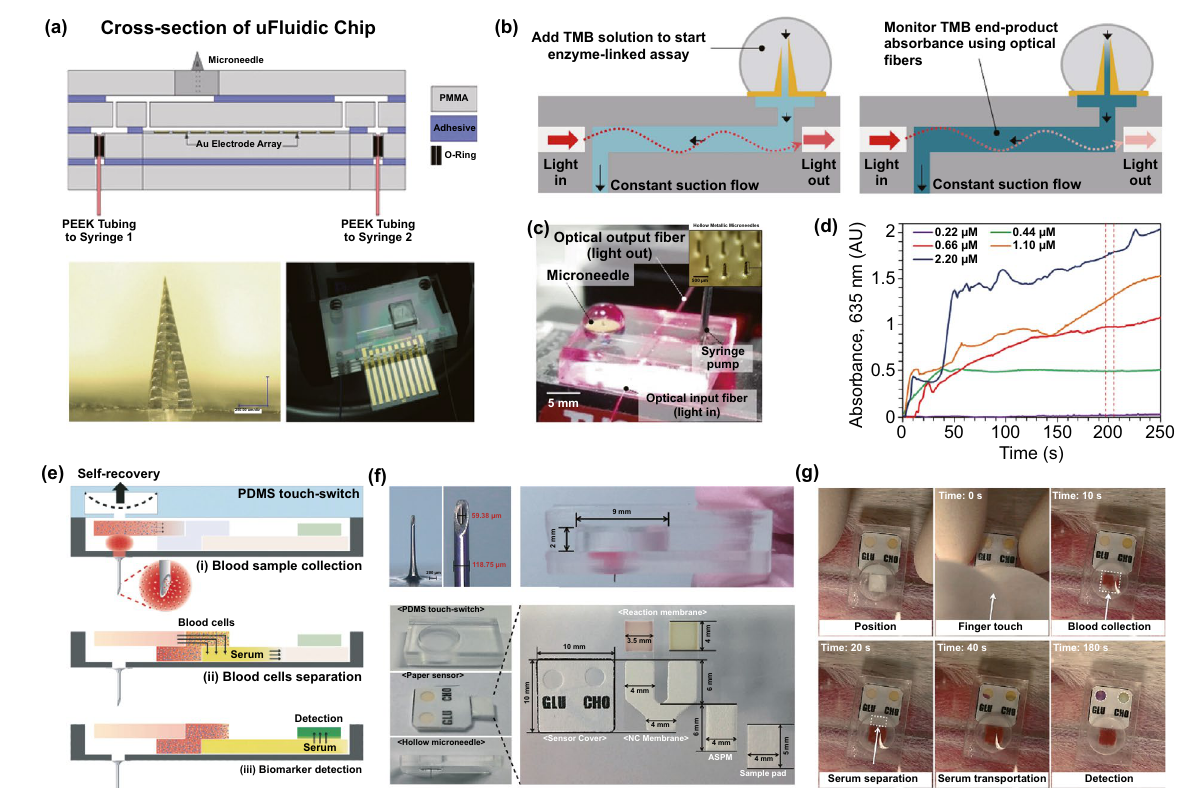
Fig. 14 Microneedle‑based biosensors for proteins and serum analytes detection. a Hollow microneedles and fluidic channels integrated bio‑ sensor developed for myoglobin/troponin detection in ISF [240]. b–d Hollow‑microneedle‑optofluidic biosensor for rapid in vitro vancomycin (VAN) sensing [241]. b Cross‑sectional schematics of the device and the mechanism of optofluidic analyzing. c Image of integrated device while analyzing. Inset: the micrograph of the hollow microneedles. d Absorbance spectra of different concentration of analytes binding to the microneedle‑lumen. e, f A fully integrated, one‑touch‑activated blood multidiagnostic system based on hollow microneedle and paper‑based sen‑ sors [242]. e Mechanism and operating process of the OBMS. f Components of the OBMS. g Application of the OBMS in the diagnosis of glu‑ cose and cholesterol in vivo in rabbit ear arteries. Reproduced with permission from Refs. [240–242], copyright (2016) Wiley‑VCH Publishing Group, (2016) Nature Publishing Group and (2015) The Royal Society of Chemistry Publishing